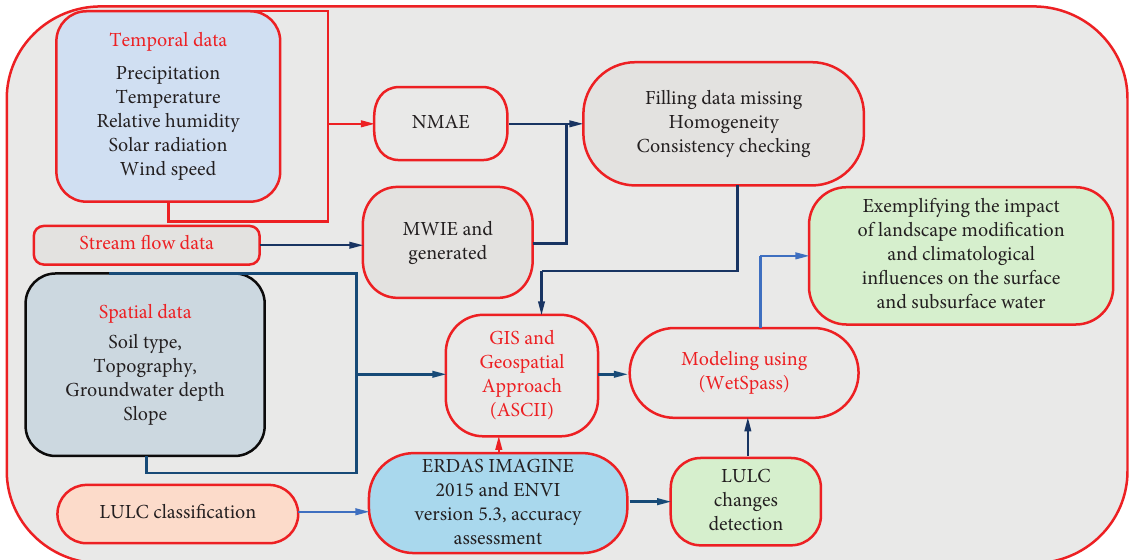
Figure 2: Flowchart methodology for exemplifying the impact of landscape modification and climatological influences on the surface and subsurface water. Table 1: Available meteorological stations within the study area. Sl.